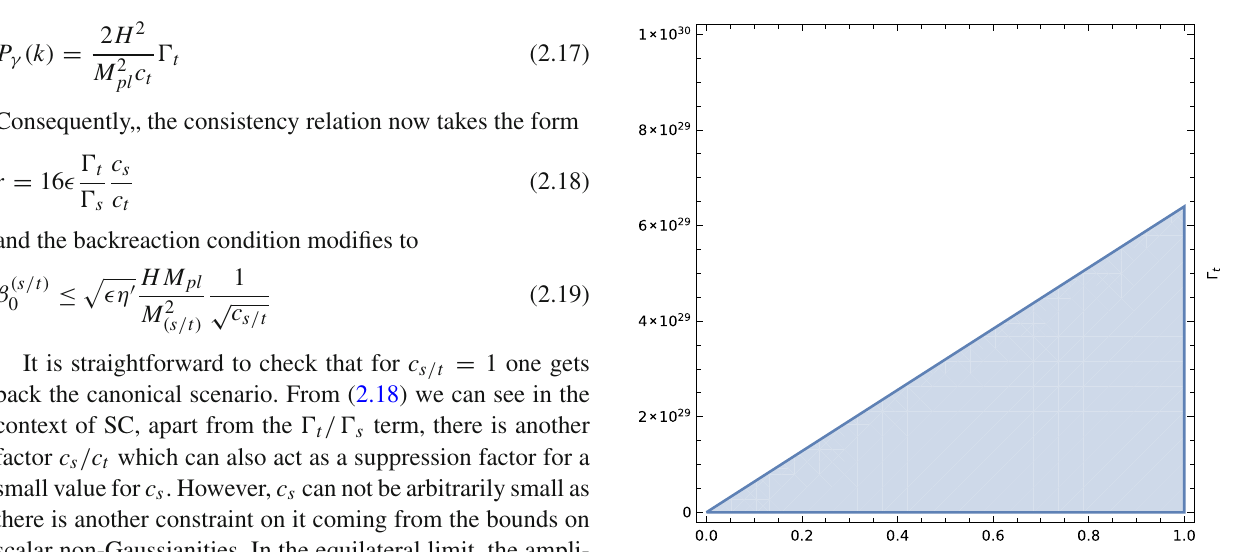
and c t using Planck constraint on the 0